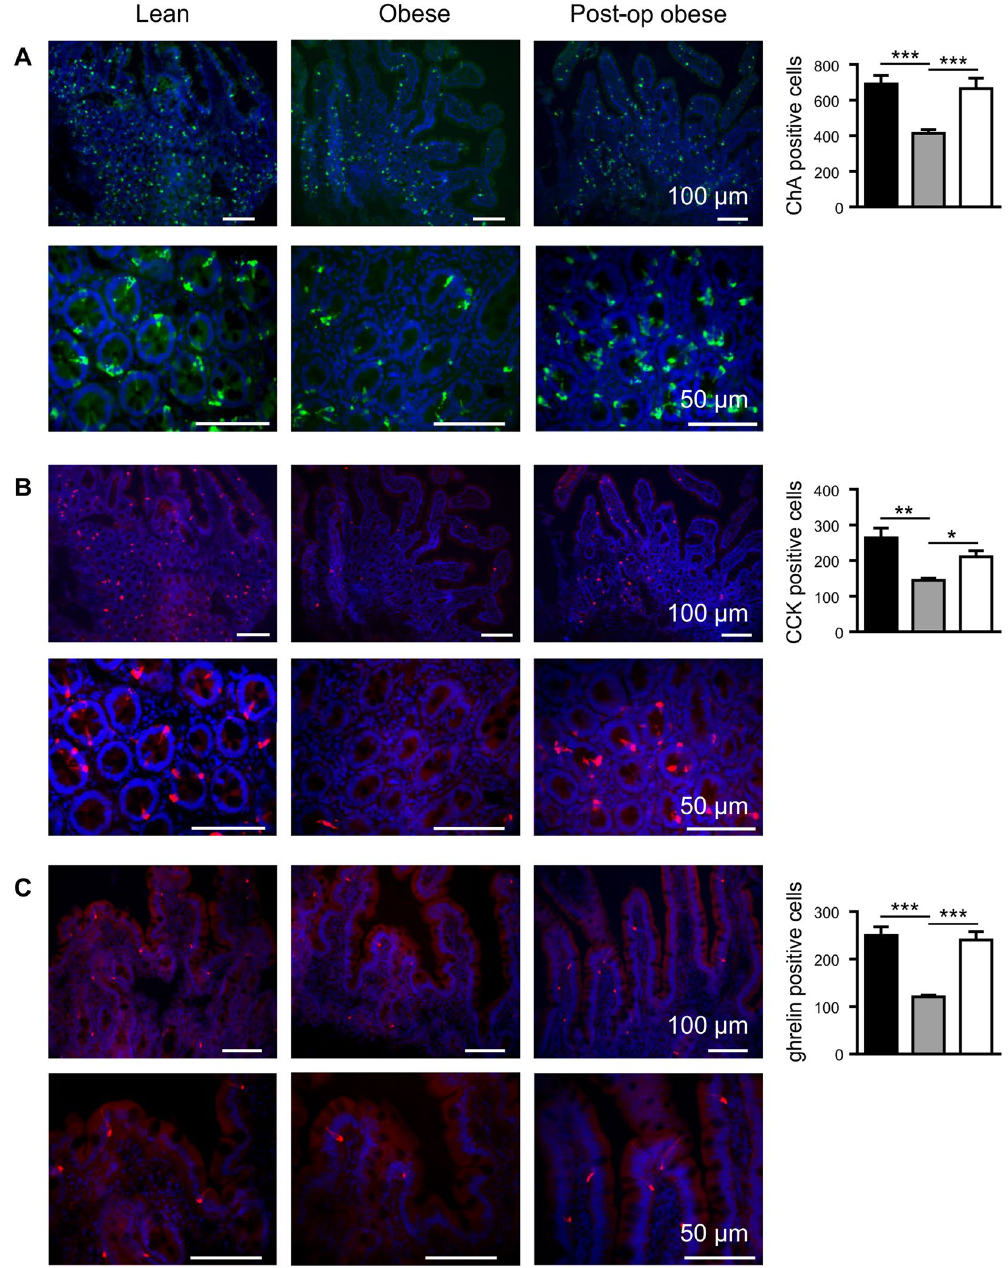
Figure 1. Expression of chromogranin A, CCK and ghrelin proteins in human duodenal biopsies. Profile of the enteroendocrine cell marker, chromogranin A ( A , ChA) and the gut hormones CCK ( B ) and ghrelin ( C ), was determined in the duodenal biopsies of lean ( ■ ), obese ( ) and post-operative obese, ( □ ) by immunohistochemistry. Bar charts (on the right) show number of cells counted expressing ChA or gut hormones. Statistical significance was determined by a One-way ANOVA with differences between means identified using a Holm-Sidak multiple comparison post-test where, * p < 0.05, ** p < 0.01 and *** p < 0.001. Scale bars are either 100 or 50 µ m. Nuclei are stained blue with 4 ′ ,6-diamidino-2-phenylindole